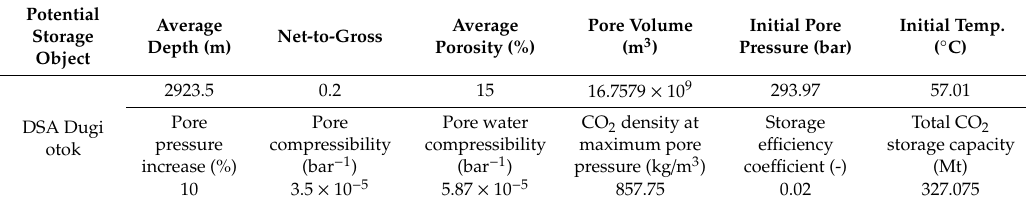
Table 2. Characteristics of the regional deep saline aquifer Dugi